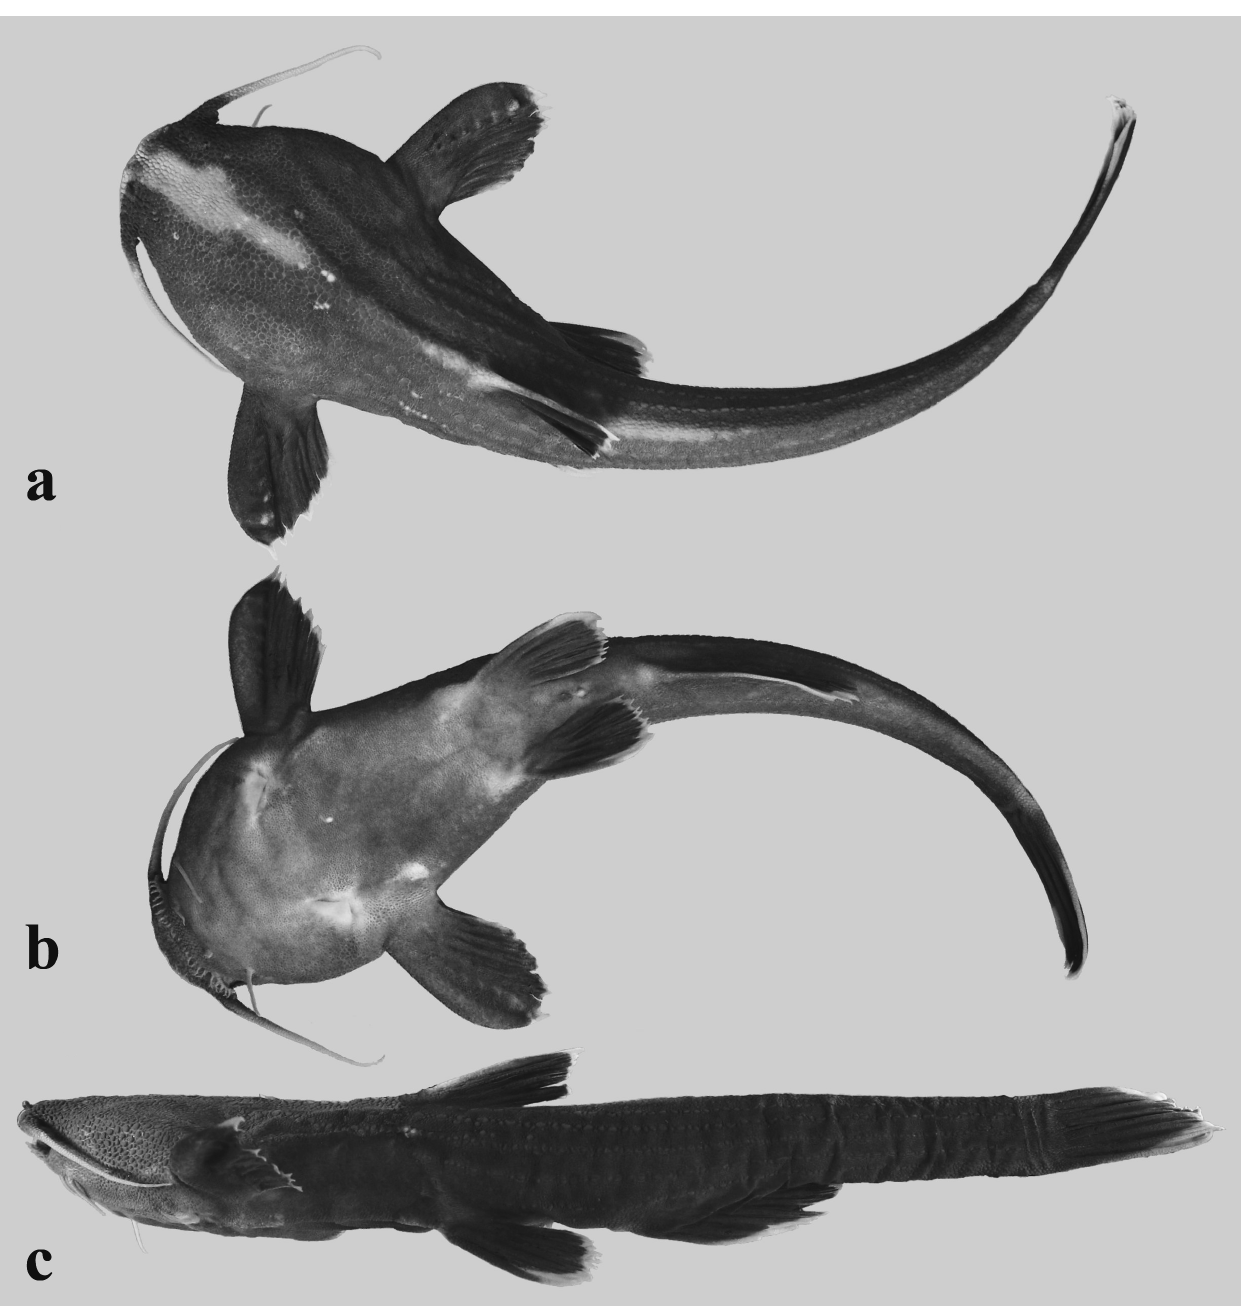
Fig. 1. Xyliphius anachoretes new species, holotype, MNRJ 31923, 88,4 mm SL: Brazil, Goiás State, rio Tocantins below the dam of Serra da Mesa Hydropower Plant, in a marginal pond at the mouth of rio Preto, a right margin tributary of the rio Tocantins (currently under water in the Cana Brava Hydropower-plant reservoir). (a) dorsal view; (b) ventral view; (c) lateral